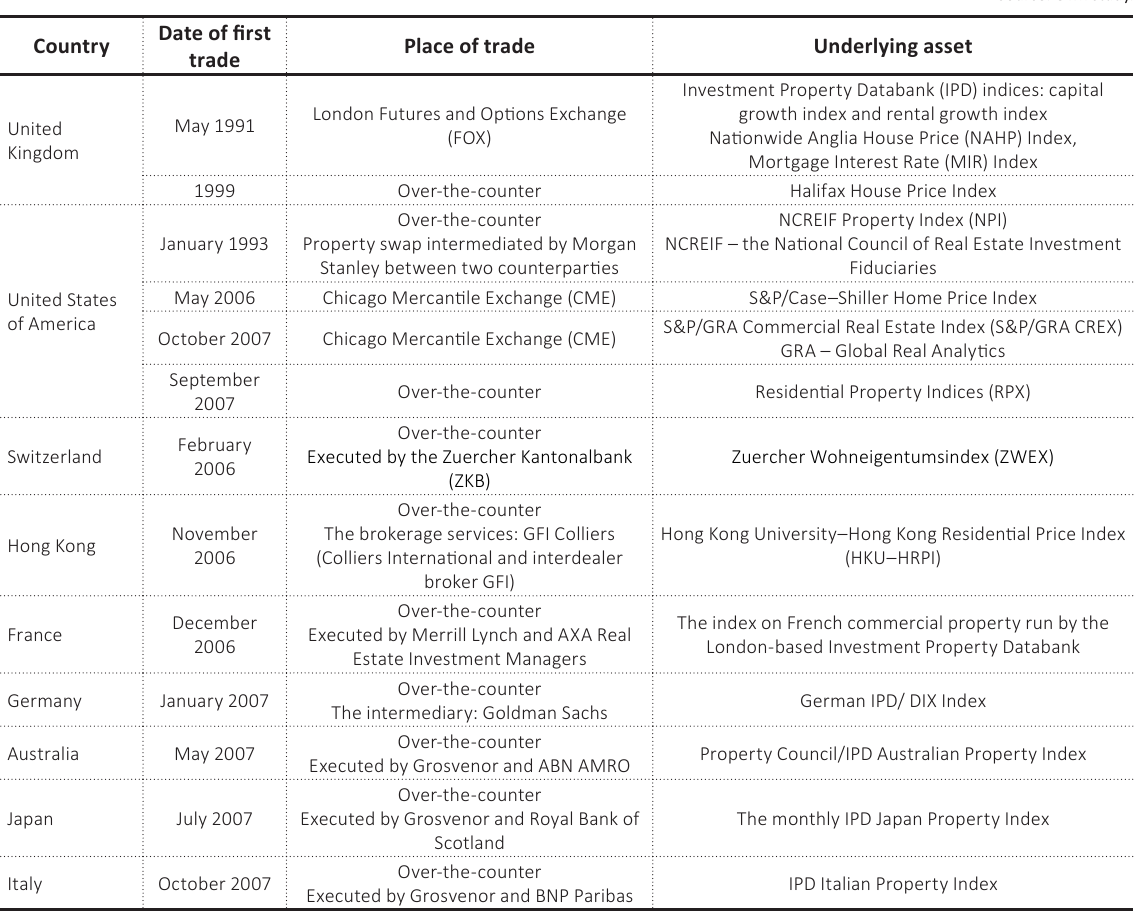
Table 1. The overview of the introduction of real estate derivatives